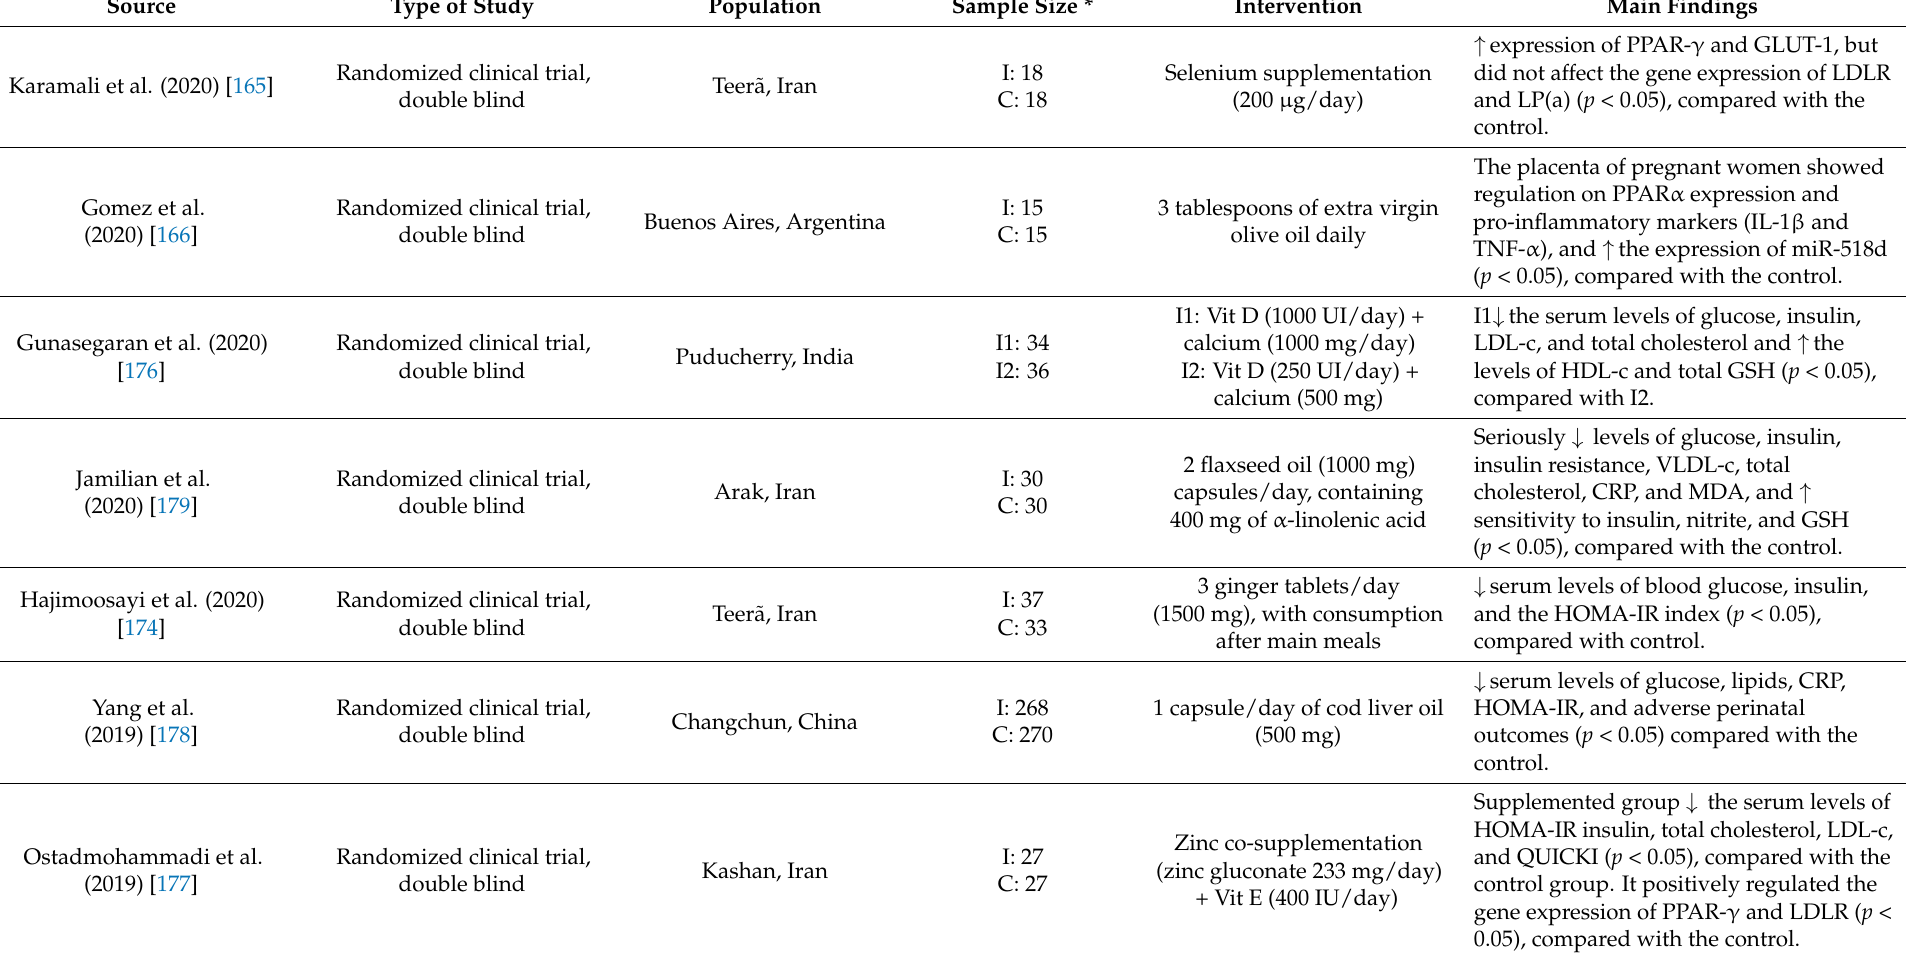
Table 2. Randomized clinical trials with alternative therapies for the treatment of